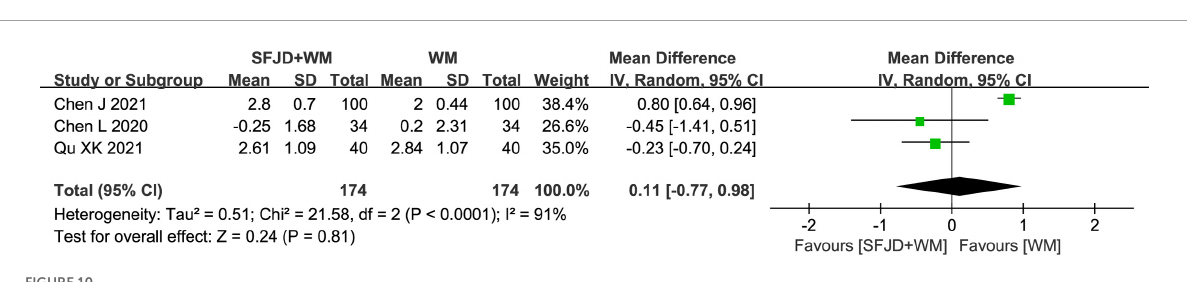
FIGURE10 Meta-analysis on WBC in the SFJD + WM group vs. the WM group in COVID-19 patients (random effect